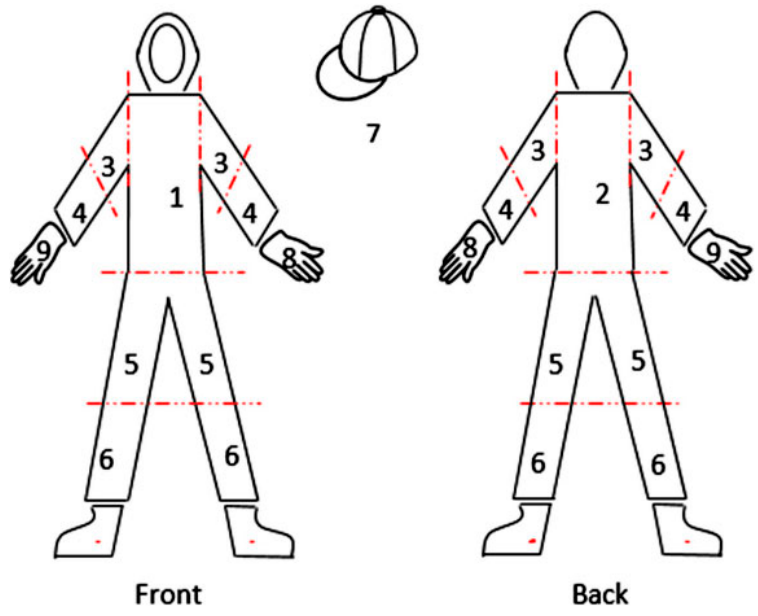
Figure 2. Garment sectioning for whole-body analysis.